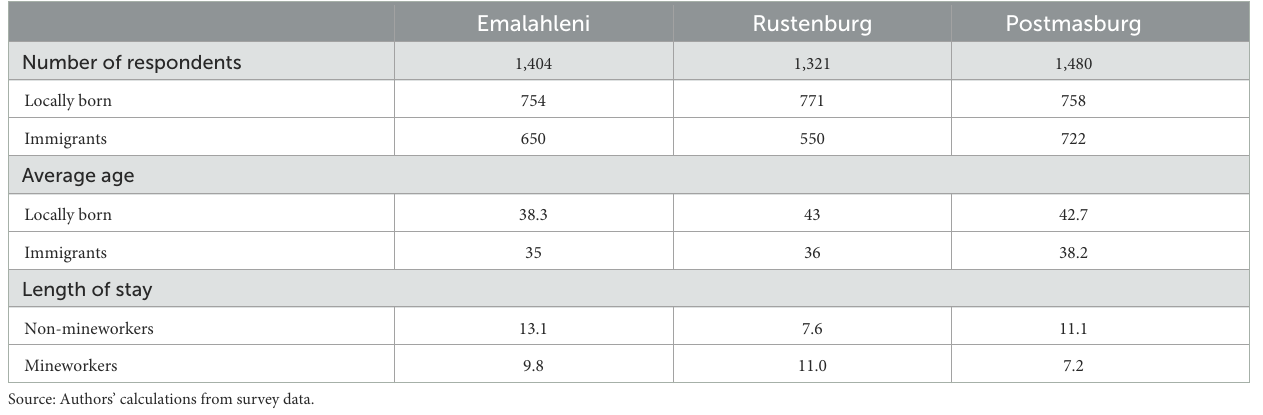
TABLE 1 Demographic characteristics of locals and migrants at the three mining communities.